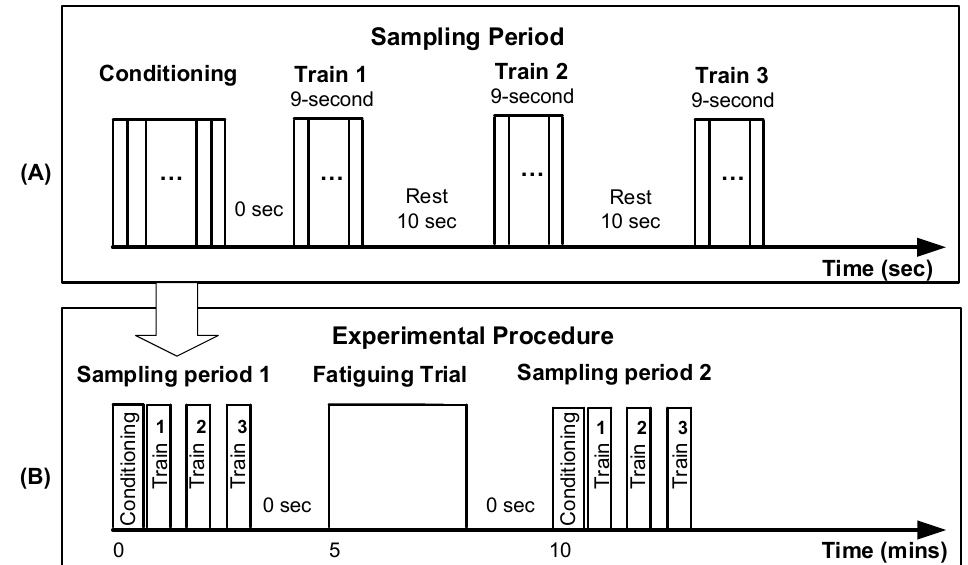
Figure 2. Illustrations of the overall experimental procedure: ( A ) muscle stimulation measurement protocol during one sampling period; ( B ) entire experimental procedure. No rest period was provided between the stimulation sampling period and fatiguing trial.